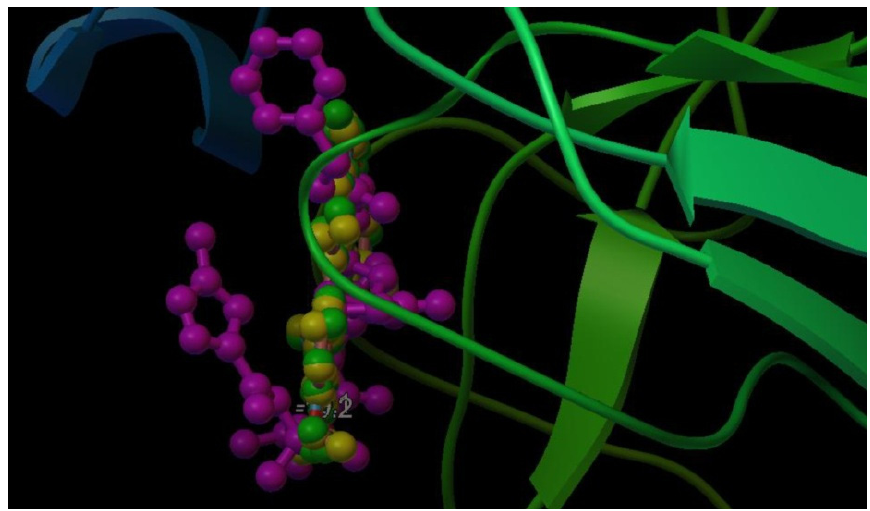
Figure 3. Interaction of N3 inhibitor (magenta), Pseudohypericin (green), and Hypericin (yellow).